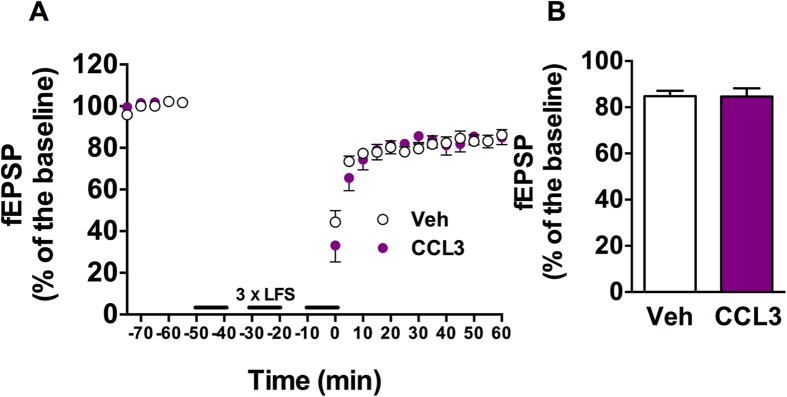
CCL3 does not impact long-term depression.(A) LTD was evoked using LFS consisting of three train of 1500 pulses at 2 Hz delivered every 10-min between each train in normal condition or in the presence of CCL3 (50 ng/mL). In order to normalized the pre-LTP or pre-LTD signal between different slices, an I/V curve was realized before baseline recording to adjust the intensity of the stimulus of each experiment to elicit a fEPSP of 35% of the maximum. This intensity was kept constant throughout the CCL3 application. Each point represents the average of 3 responses (mean ± SEM) evoked every 30 s in seven different slices. (B) Effect of CCL3 on fEPSP after 60 min post LFS (n = 7 for each condition).